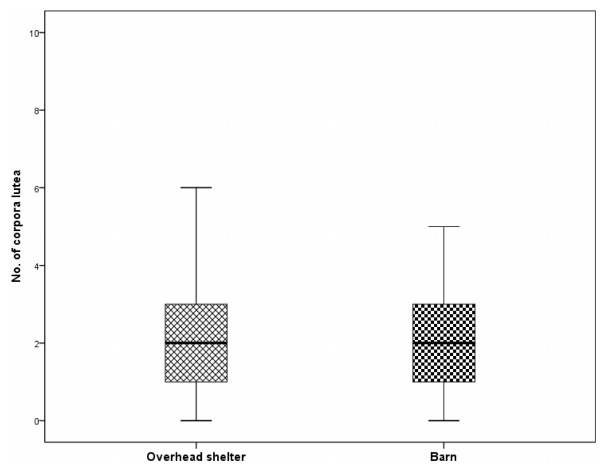
Figure 2. The distribution of corpora lutea in ewes kept in the over- head shelter and in the barn.